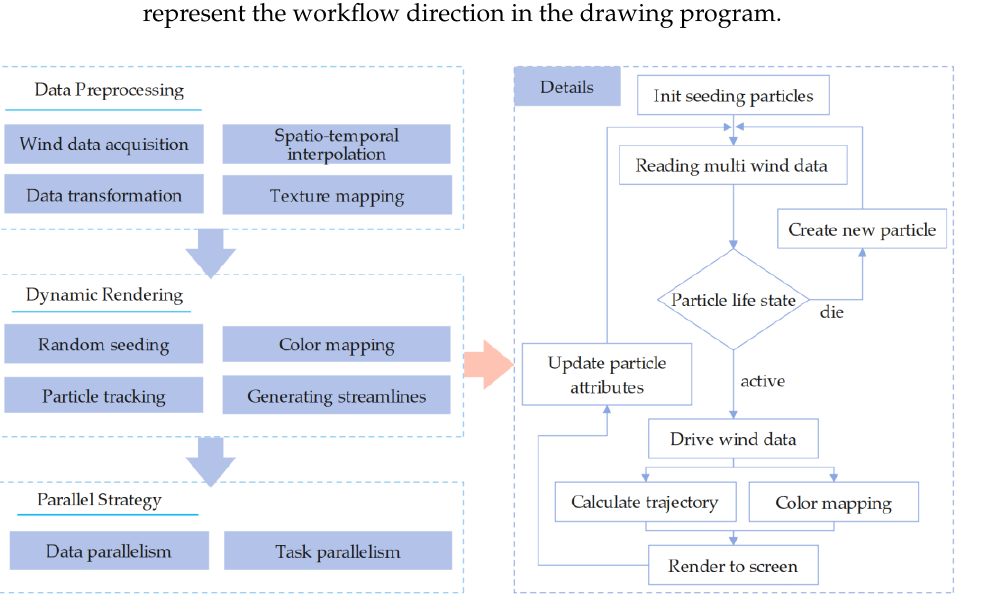
Figure 1. Overview diagram for spatio-temporal dynamic visualization based on particle